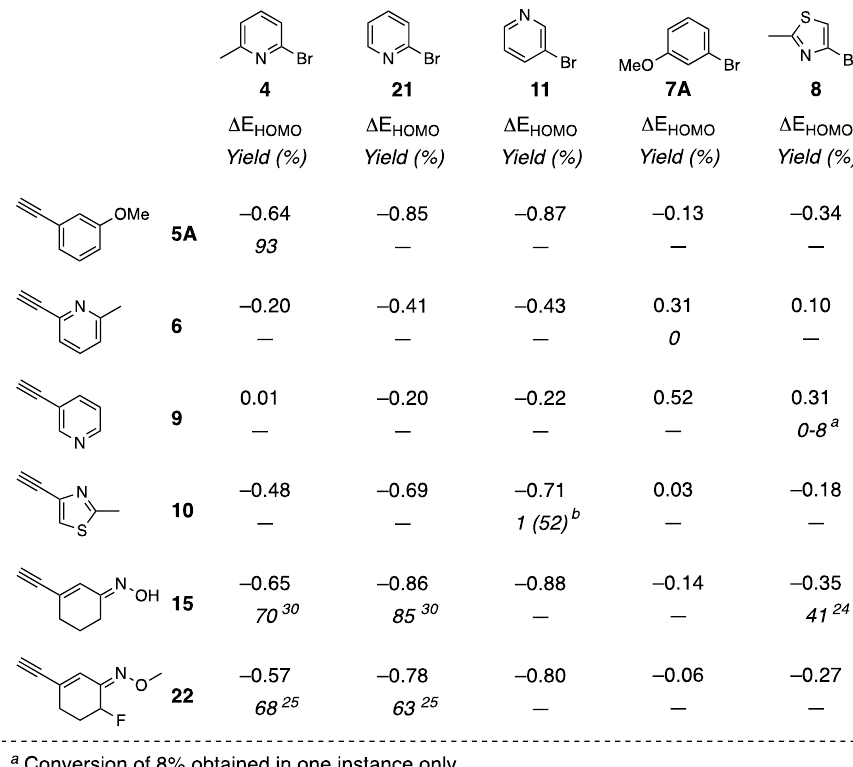
Figure 3 Difference in values of HOMO energies of reacting partners (ΔE HOMO ) calculated using DFT method compared to experimental yields. Note: “—” indicates that reaction was not performed experimentally.